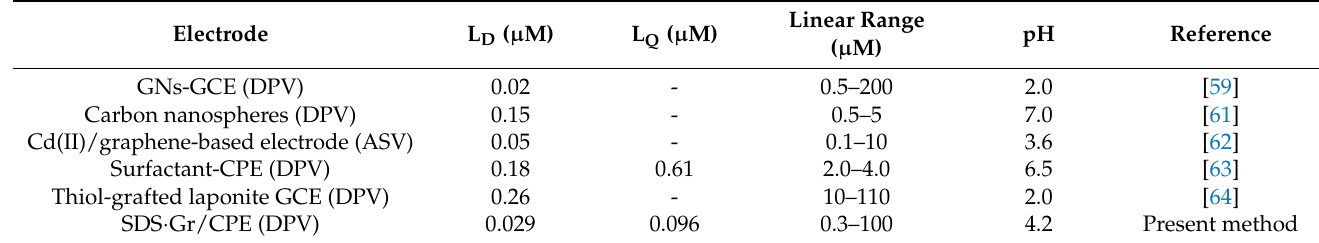
Figure 6. ( A ) Differential pulse voltammograms depicting variation in CIP concentrations ranging from 0.6 to 7 µ M using PBS of pH 4.2 at SDS · Gr/CPE. ( B ) Dependence of I p on concentration (at a lower concentration). Table 2. Comparative study of detection limits with other reported works.